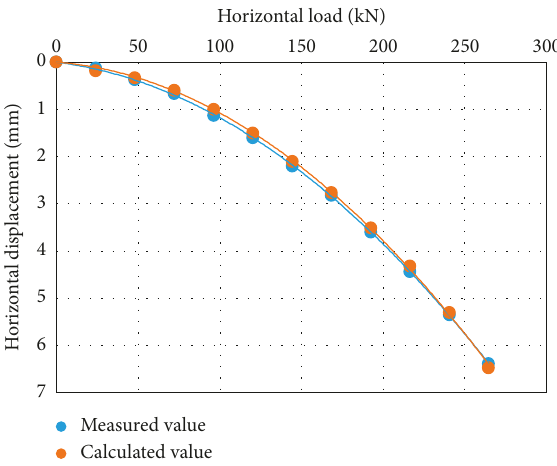
Figure 9: Relationship curve for horizontal load and